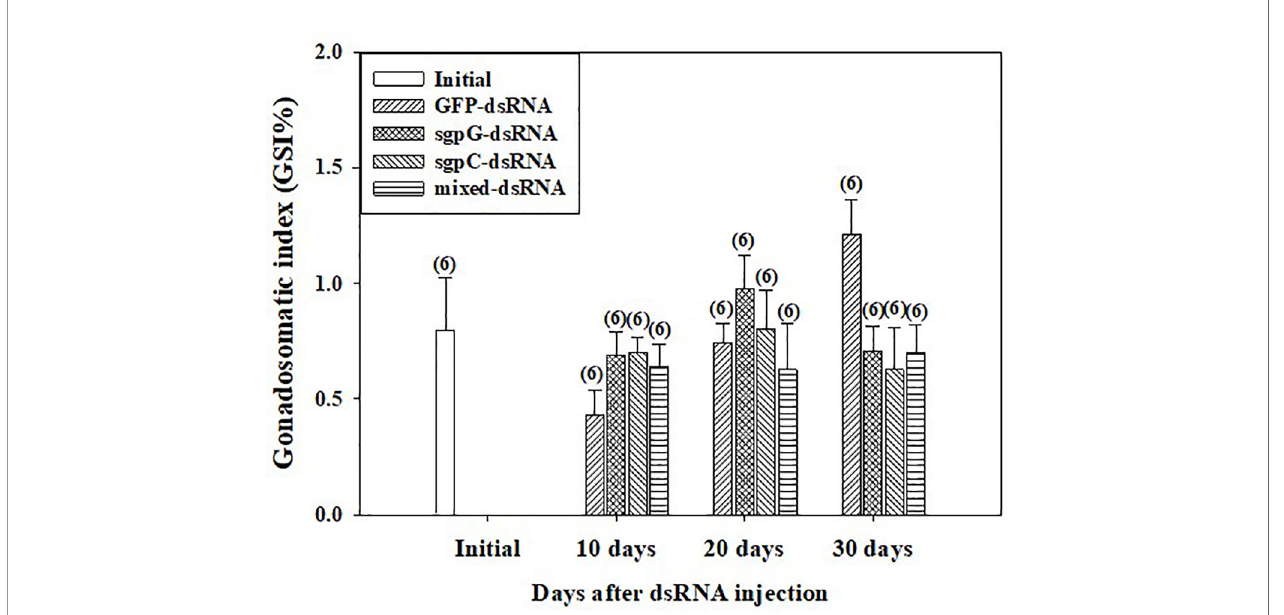
FIGURE 3 | Changes in gonadosomatic index (GSI) following a single injection of GFP-dsRNA, sgpG-dsRNA, sgpC-dsRNA, mixed-dsRNA, or no injection (initial). Results are expressed as the mean ± SEM. Values in parentheses indicate numbers of shrimp analyzed in each group. The content of each treatment group is indicated in the legend box that appears above the bar